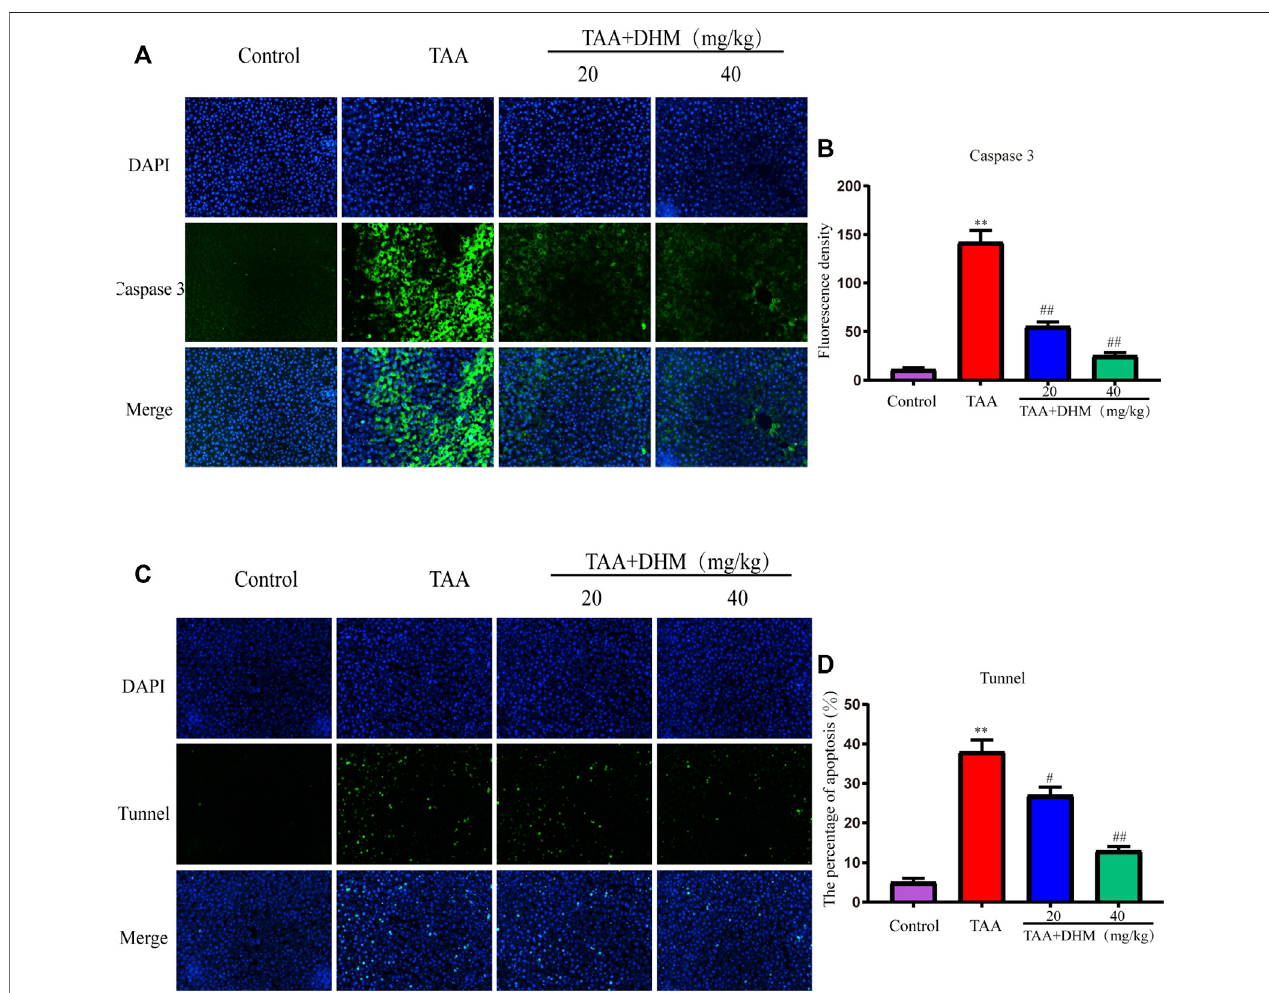
FIGURE 6 | DHM alleviated TAA-induced apoptosis of hepatocytes. The protein expression levels of caspase 3 (A) and Fluorescence density (B) , Fluorescence analysisofhepatocyteapoptosis (C) andFluorescencedensity (D) ;Datawasexpressedasthemean ± SD.Thedifferencesbetweengroupswereanalyzedbytwotailed T-test or one-way analysis of variance (ANOVA). ** p < 0.01, * p < 0.05 versus control group; ## p < 0.01, # p < 0.05 versus TAA